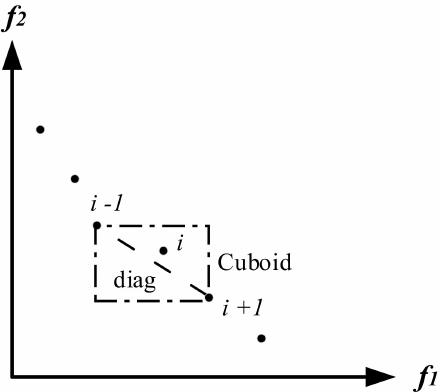
Figure 4. The estimation of crowding distance.